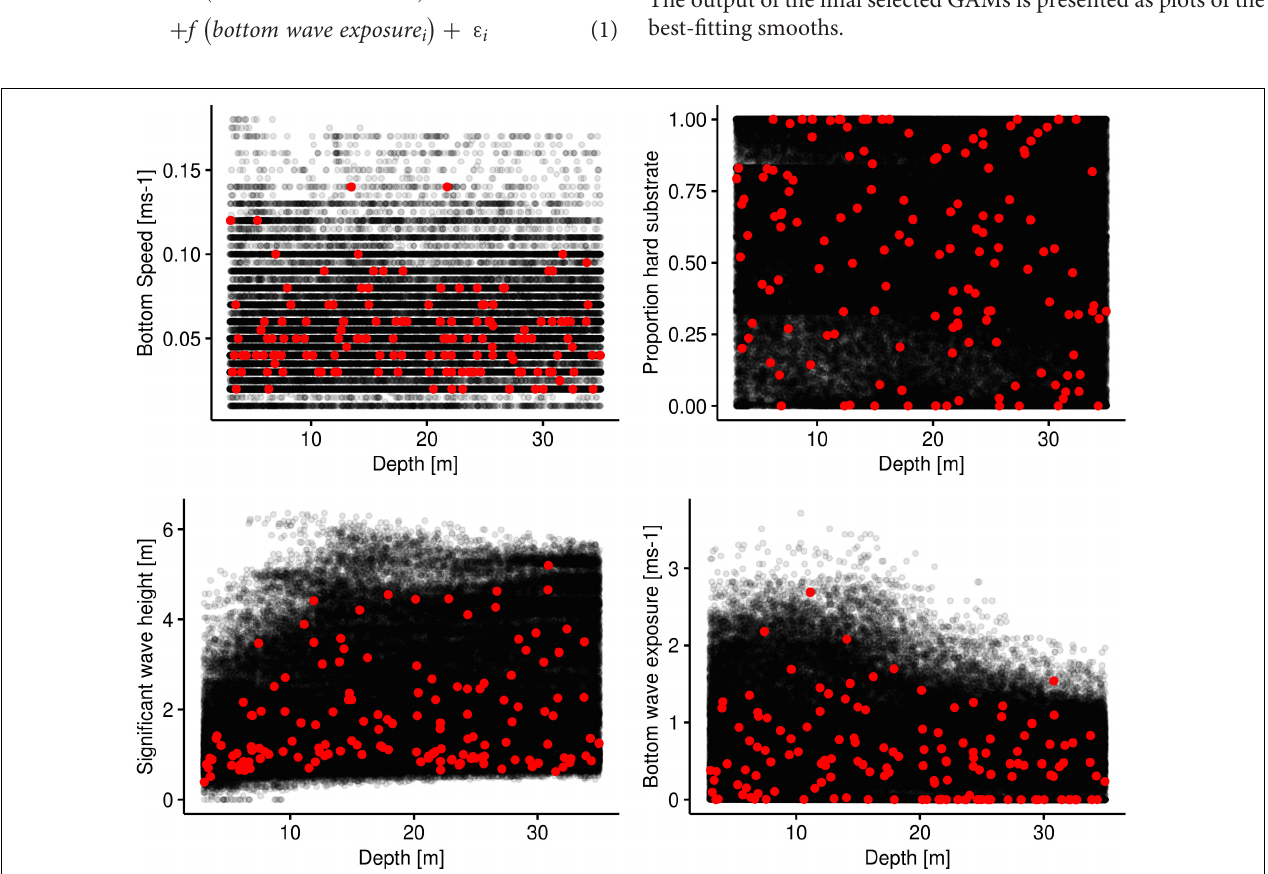
FIGURE 4 | Environmental covariate space plots. Depth is used as the base covariate for which each of the remaining covariates are plotted against. The black dots represent the realised environmental combinations in the study area of the two covariates in question. The red dots represent the values at the sampled sites. The black dots are plotted with a transparency of 0.1. TABLE 3 | Statistical summary of fitted GAM models and their predictive performance.